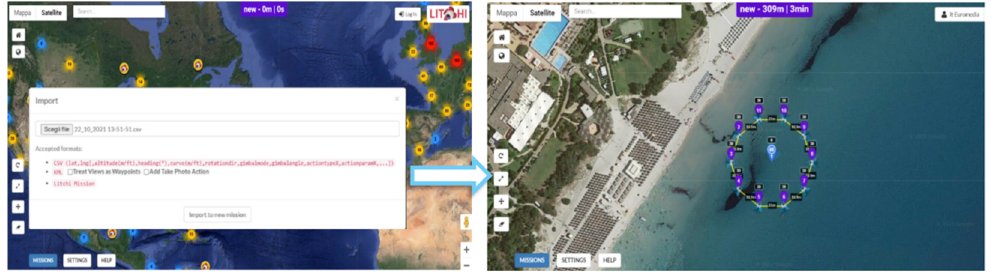
Figure 7. Loading the mission on Litchi.